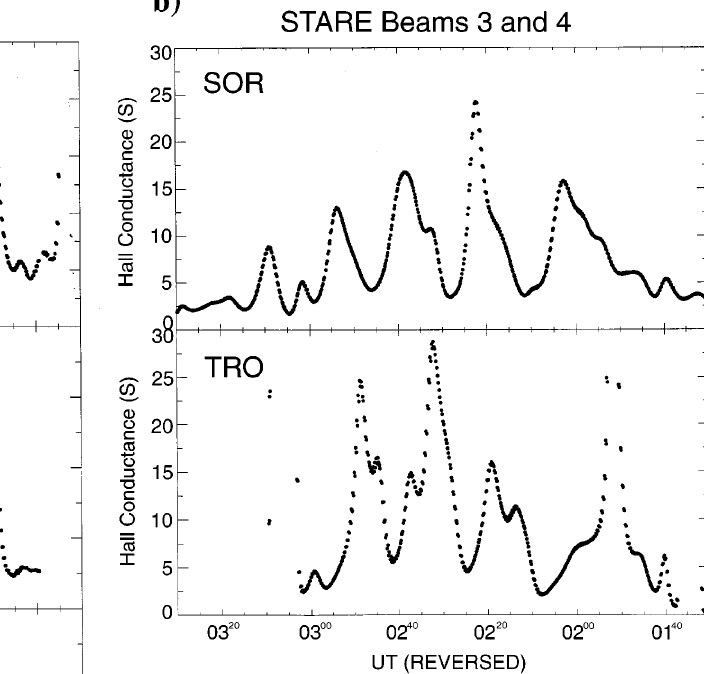
Fig. 7. a Ionospheric Hall conductances derived from CUTLASS beam 9, l-o-s velocities and IMAGE magnetometer data. Presented are BJN ( top panel ), SOR ( centre panel ), and TRO ( bottom panel ). b Ionospheric Hall conductances derived from STARE beam 4 and SOR ( top panel ) and STARE beam 3 and TRO ( bottom panel ). BJN, SOR and TRO are located at magnetic latitudes of 71.3 (cid:176) , 67.1 (cid:176) and 66.4 (cid:176) respectively. CUTLASS derived profiles are directly comparable as all l-o-s velocities are drawn from a single beam whereas STARE derived profiles represent simultaneous measurements from two separate locations (see text for description). Conductance scales are not uniform for